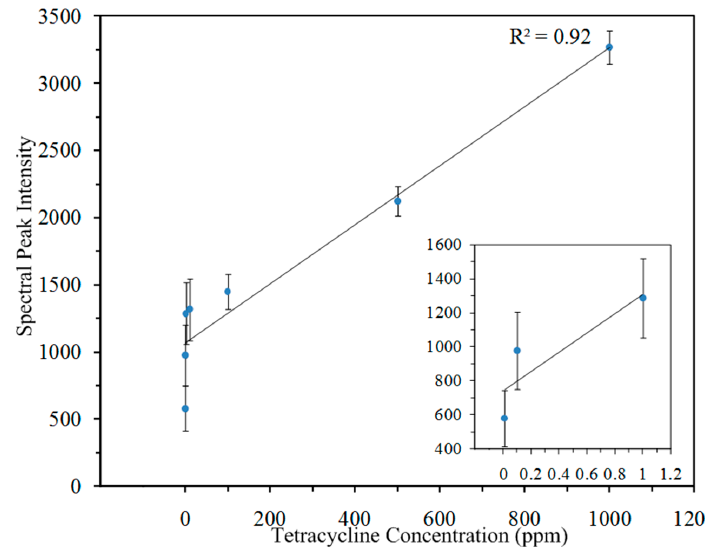
Figure 6. Linear relationship between tetracycline peak intensity at 1285 cm − 1 and its concentration in water. Inset: 0.01 ppm, 0.1 ppm and 1 ppm.